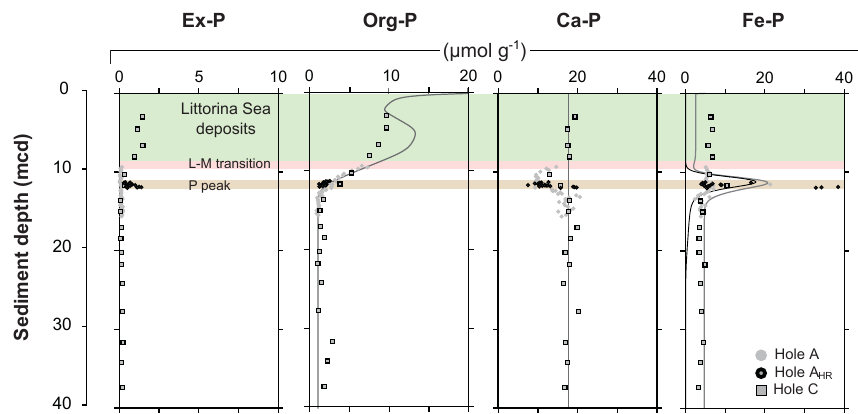
Figure 6. The phosphorus fractionation in the sediments for holes A and C, including exchangeable P (Ex-P), organic P (Org-P), authigenic and detrital Ca-P (Ca-P) and Fe-bound P (Fe-P). Grey lines show profiles from our model (vivianite trend in black). These phosphorus phases were determined according to the P extraction method of Ruttenberg (1992), including modifications by Slomp et al. (1996). Hole A HR samples were taken from hole A cores more than 1 year after storage. More details on the colored areas can be found in the legend of Fig. 3.